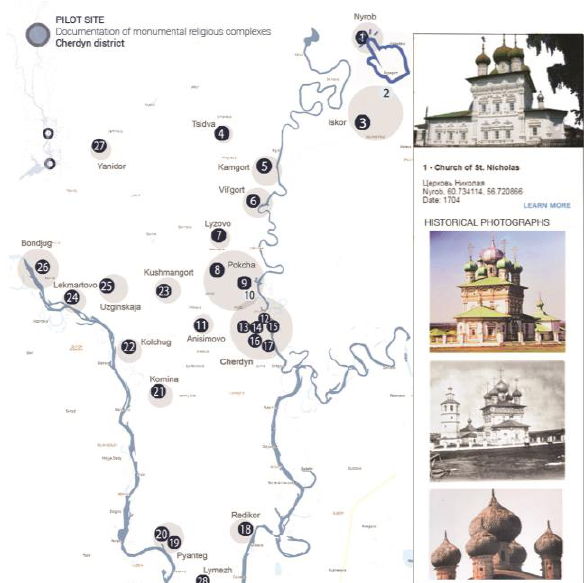
Figure 5. One of the aims of PROMETHEUS project is the creation of interactive maps to which information about religious monumental complexes can be associated.